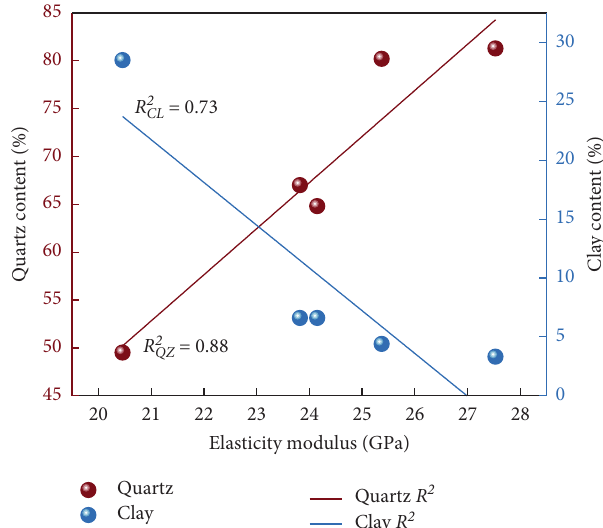
Figure 8: Modulus of elasticity as a function of quartz and clay mineral content.